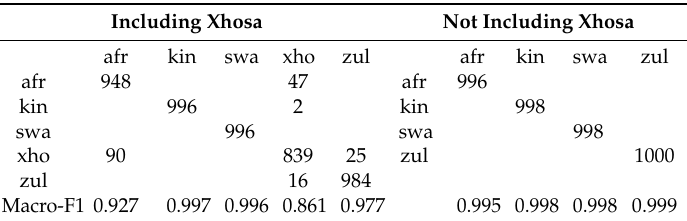
Table 28. Confusion matrix related to